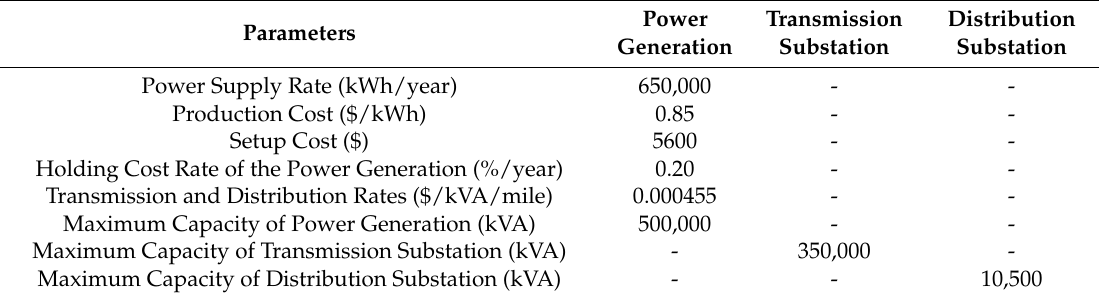
Table 2. Power Generation, Transmission Substation and Distribution Substation Data.